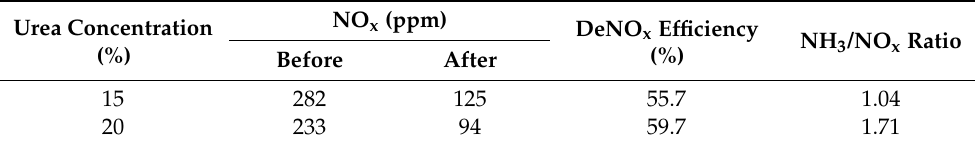
Table 4. NO x removal efficiency according to the NH 3 /NO x ratio in the SNCR process of Korean cement manufacturer G (13% with O 2